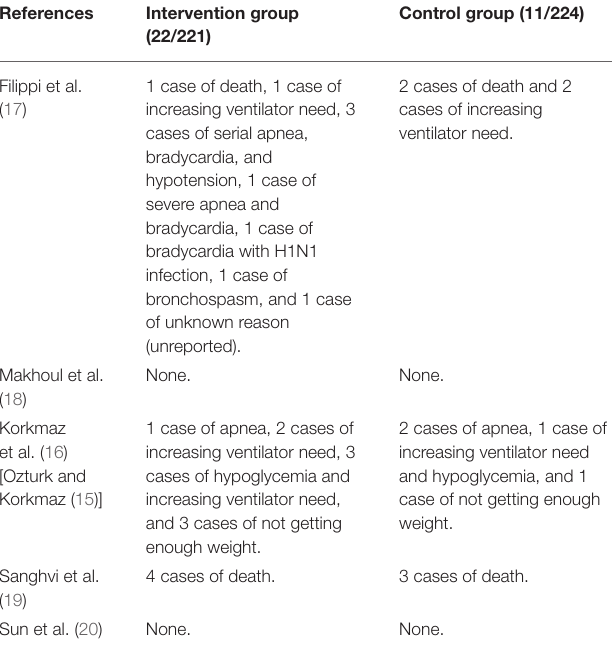
TABLE 2 | Adverse events in included